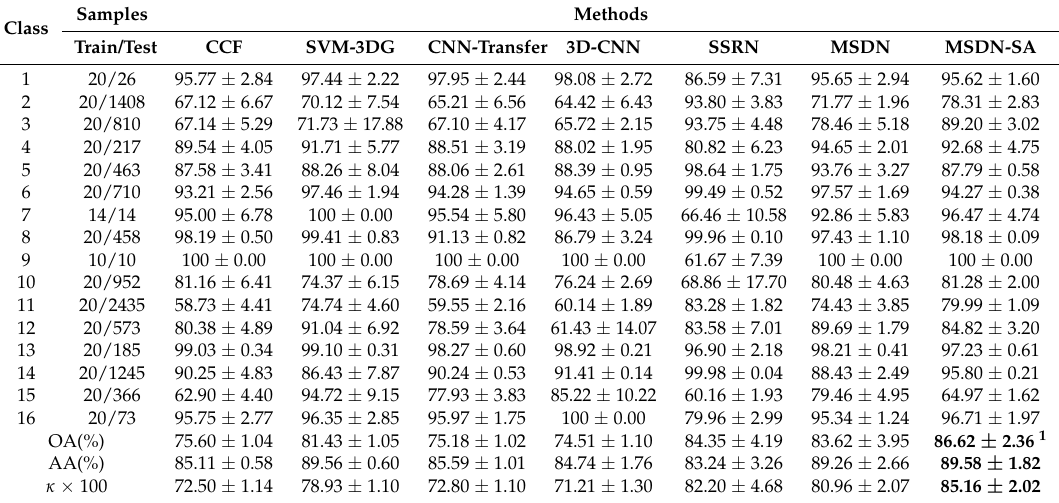
Table 2. Network architecture details of proposed MSDN-SA for Indian Pines